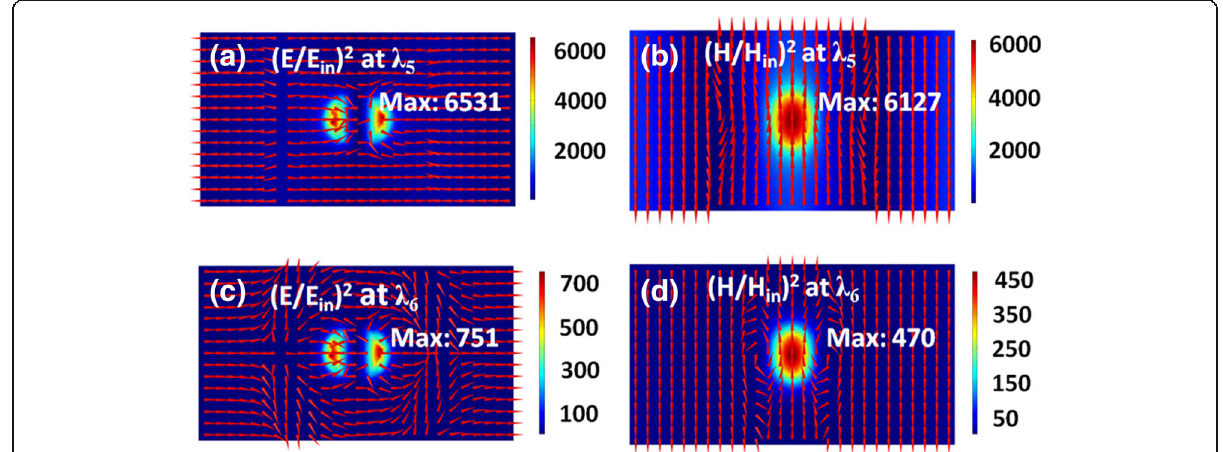
Fig. 6 a – d The same as in Fig. 4 but at the resonance wavelengths of λ 5 and λ 6 labeled in Fig.